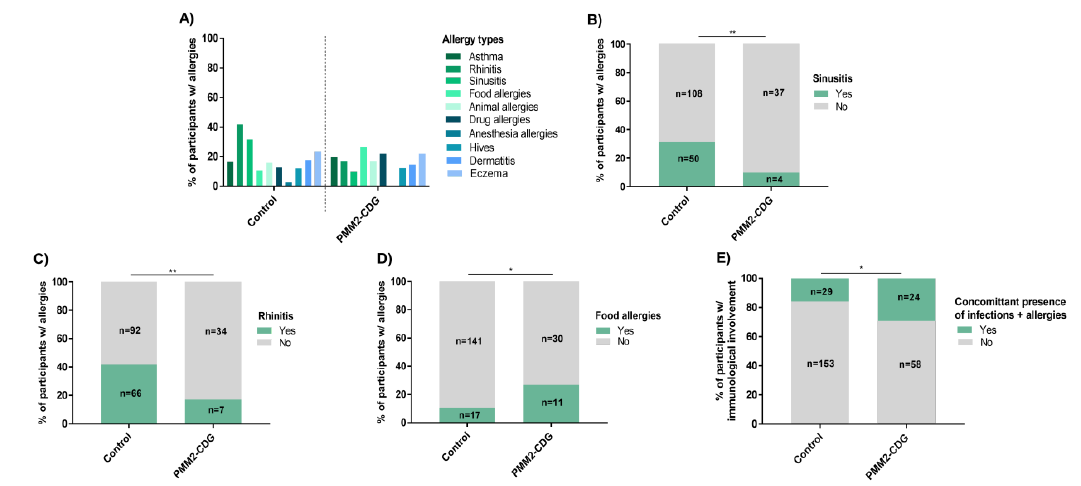
Figure 4. Allergy prevalence. ( A ) Prevalence of specific allergies in PMM2-CDG and